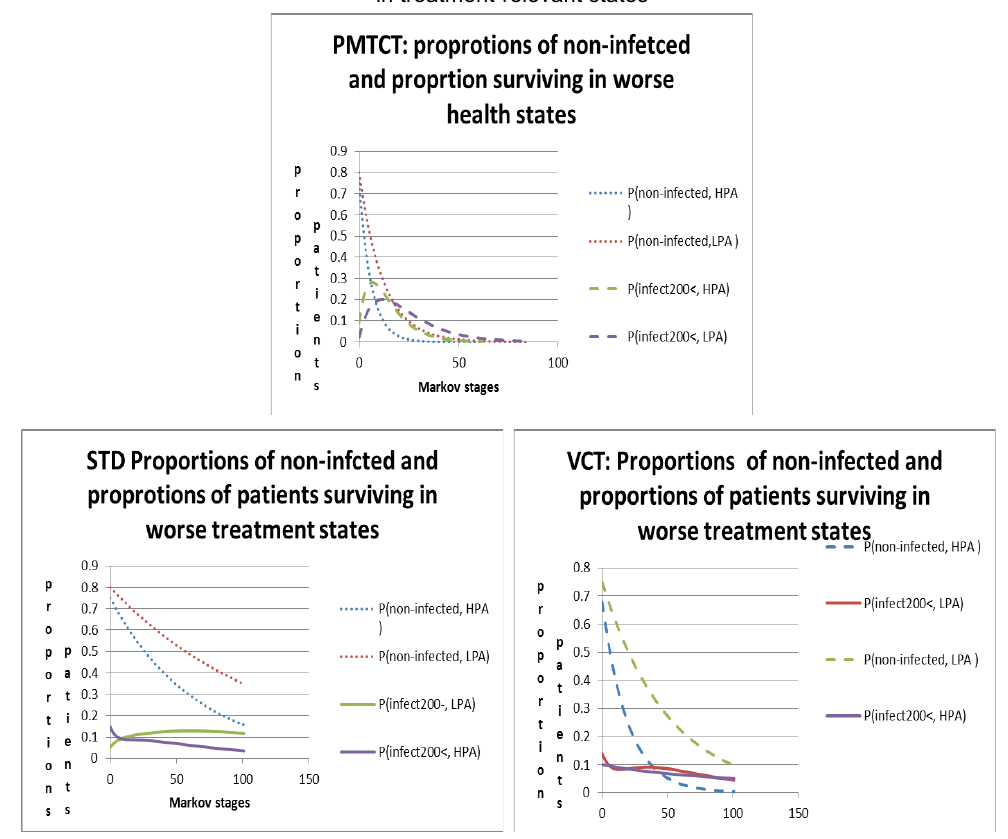
Proportions of non-infected infected (PNI) and surviving (PS) patients in treatment-relevant